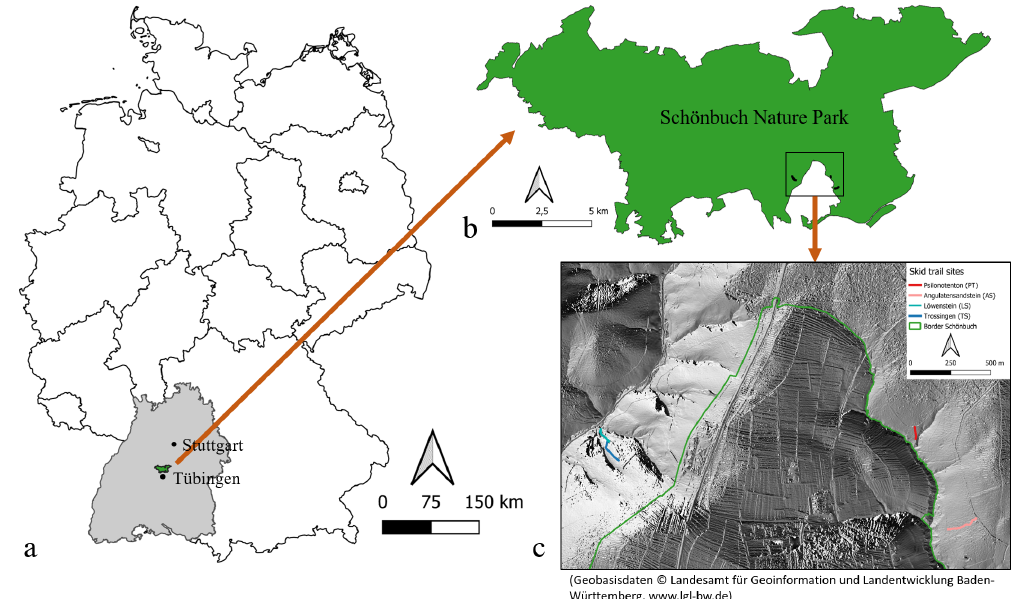
Figure A1. Overview of the study area. (a) Location of Schönbuch Nature Park in Germany. (b) Location of the selected skid trails inside Schönbuch Nature Park. (c) Location of the four skid trails on a hillshade raster (Geobasisdaten © Landesamt für Geoinformation und Landentwicklung Baden-Württemberg, https://www.lgl-bw.de).